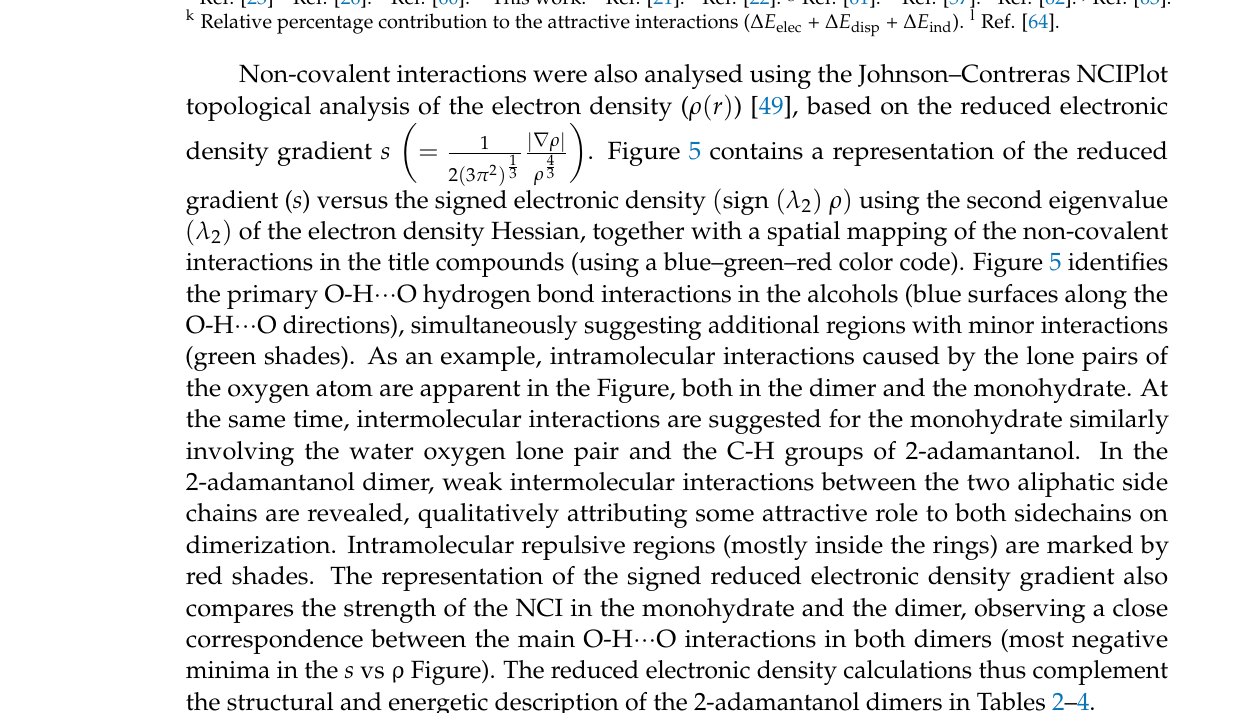
Table 4. Binding energy decomposition for the dimer and monohydrate of 2-adamantanol, and comparison with several alcohol and thiol dimers and the van der Waals dimer pyridine–methane. Clusters are ordered by interaction energy, which is decomposed into electrostatic ( ∆ E elec ), inductive (multipole interactions/charge transfer, ∆ E ind ), exchange repulsion ( ∆ E exch ) and dispersion ( ∆ E disp ) energy terms. The calculation used SAPT(2) + 3/aug-cc-pVDZ//B3LYP-D3(BJ)/def2-TZVP (all values in kJ mol − 1 ).